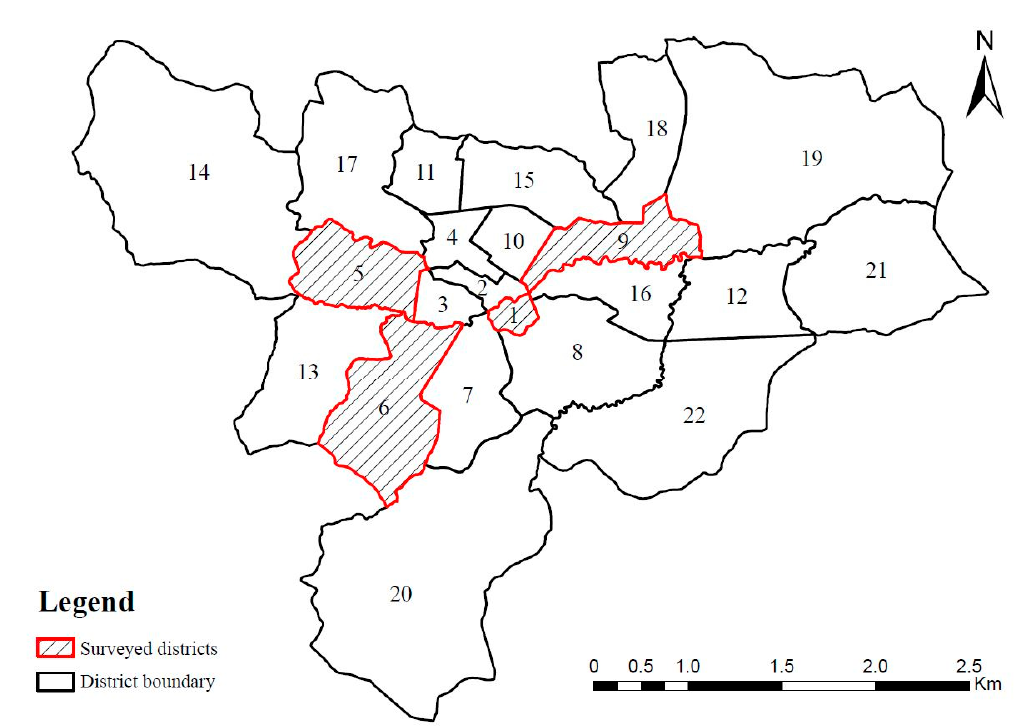
Figure 1. Map of Kabul City showing specific districts composing the study area (District 1–22).